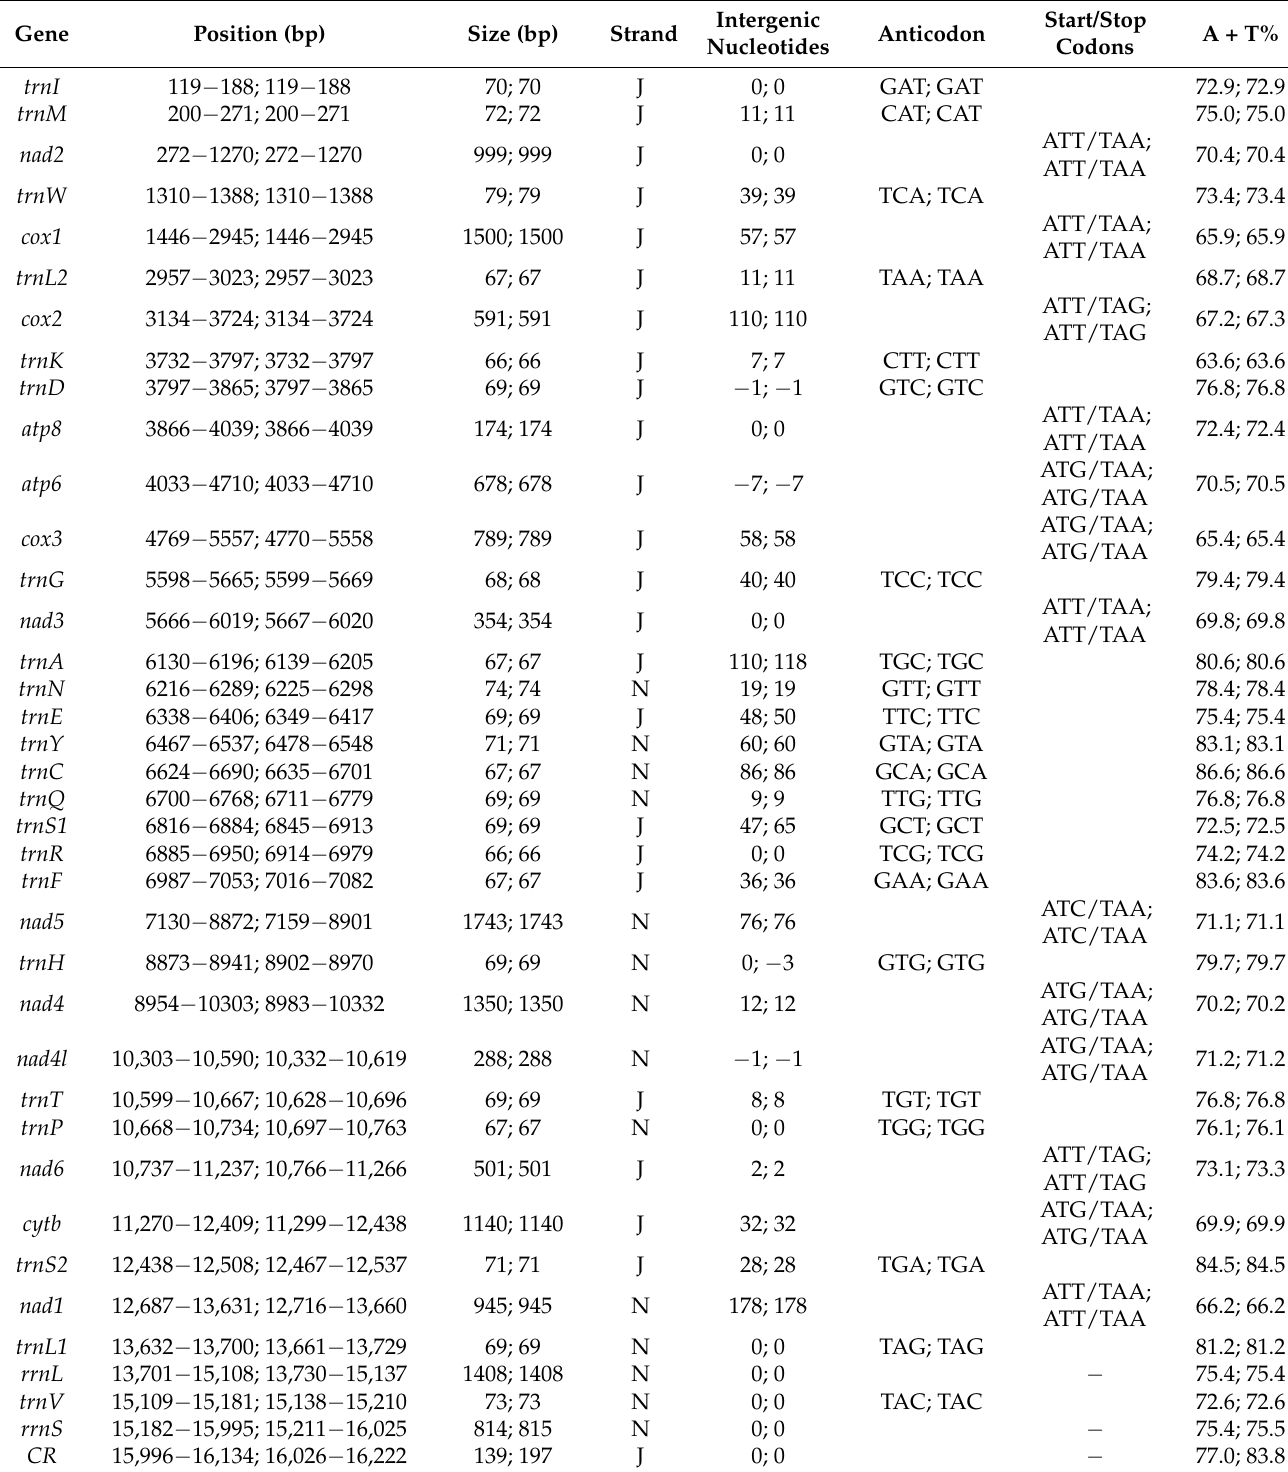
Table 2. Mitochondrial genome structure of Haplodiplatys aotouensis . Values of Fujian’s (left) and Jiangxi’s (right) samples are separated by